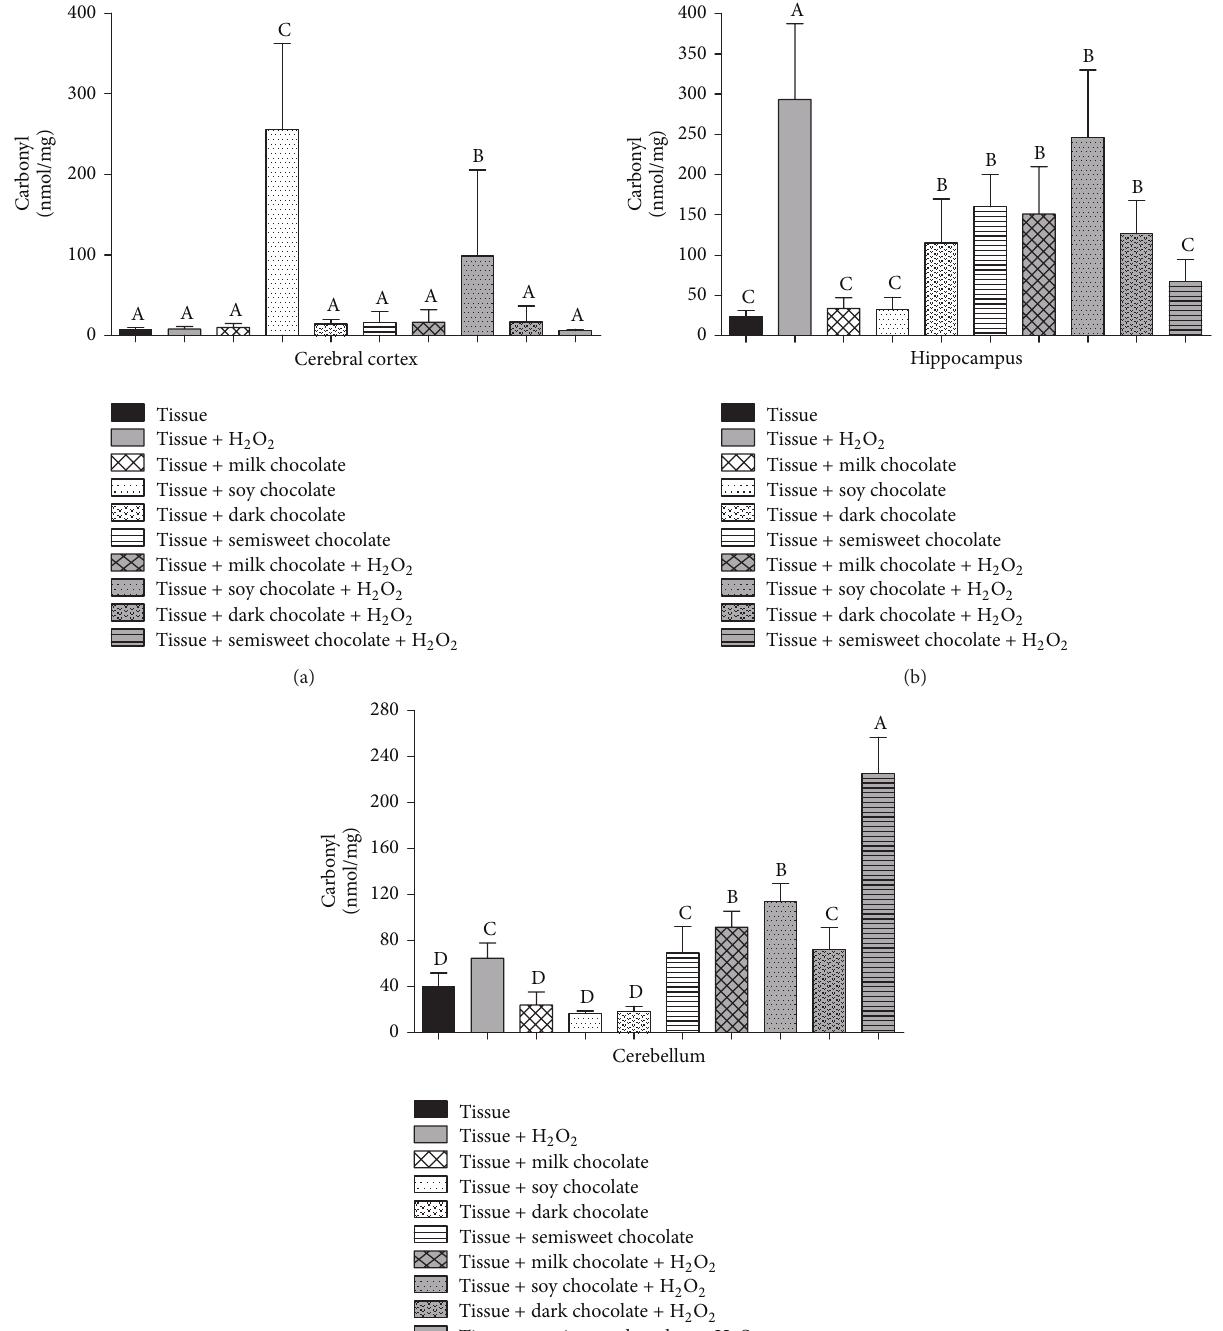
Figure 2: Levels of protein oxidation (carbonyl) in cerebral cortex (a), hippocampus (b), and cerebellum (c) of Wistar rats treated with different chocolate types with or without hydrogen peroxide. Different letters show statistical difference between them ( 𝑝 < 0.05 ).